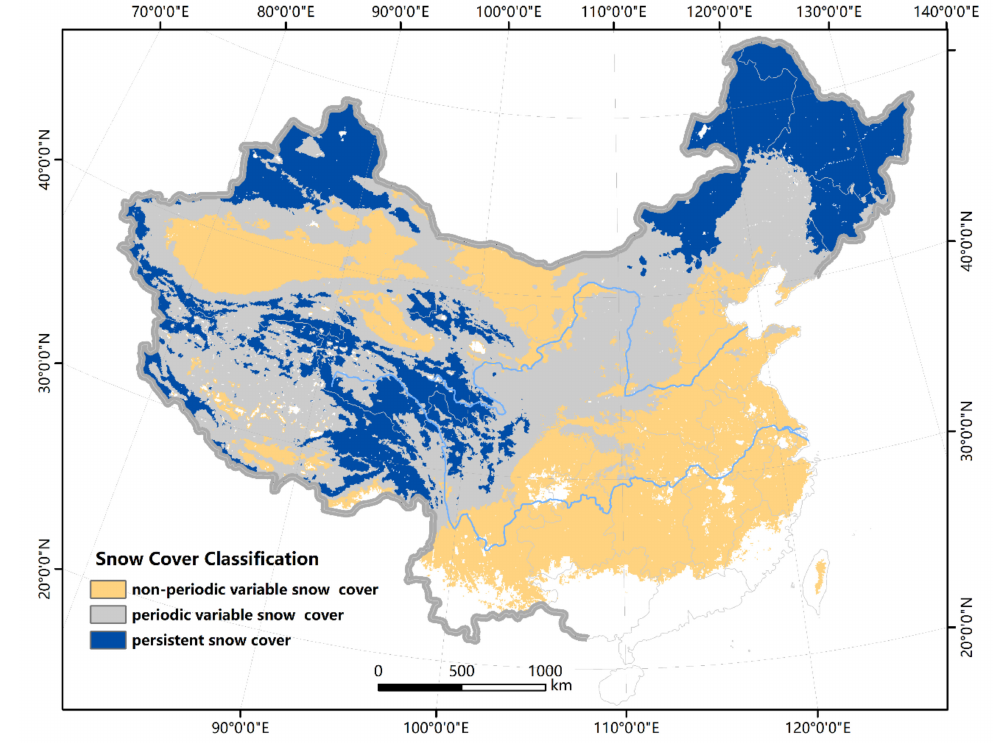
Figure 3. Distributions of the traditional snow cover classification across China during 1981–2019.